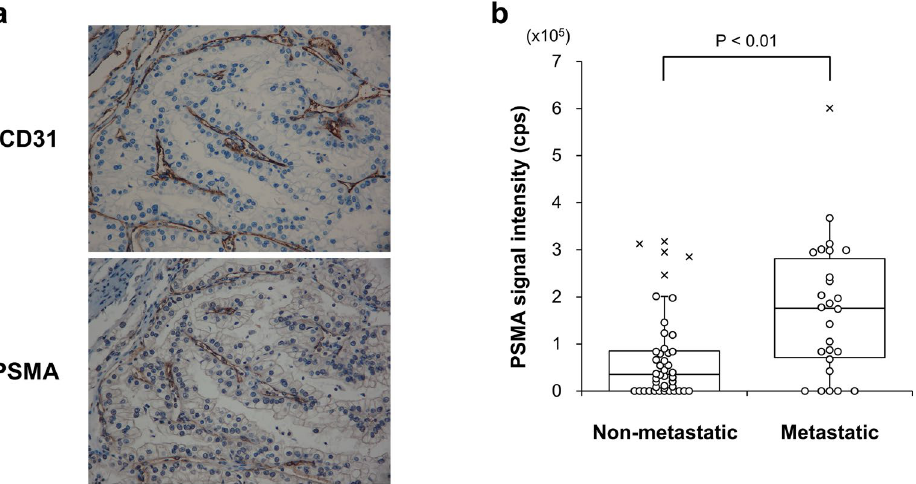
Figure 7. Measurement of the PSMA-EV levels in serum of RCC patients. ( a ) A representative image of CD31 and PSMA immunohistochemical staining is shown. ( b ) The PSMA-EV levels in serum was determined after purification of EVs from serum by Tim4. RCC patients with (n = 26) and without (n = 44) metastasis were analyzed. Data are shown in the ’box and whiskers’ graph with interquartile range (IQR: box), median (thick vertical line in the box) and 1.5 IQR (whiskers). x denotes